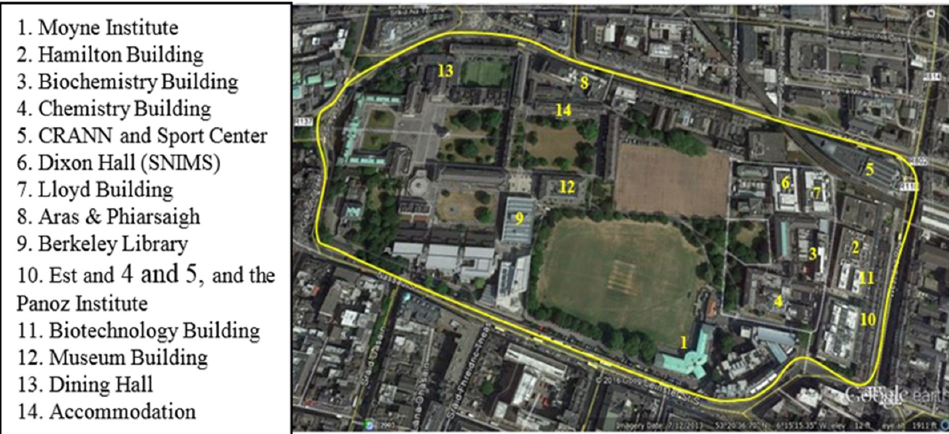
Figure 1. The boundary of TCD campus.